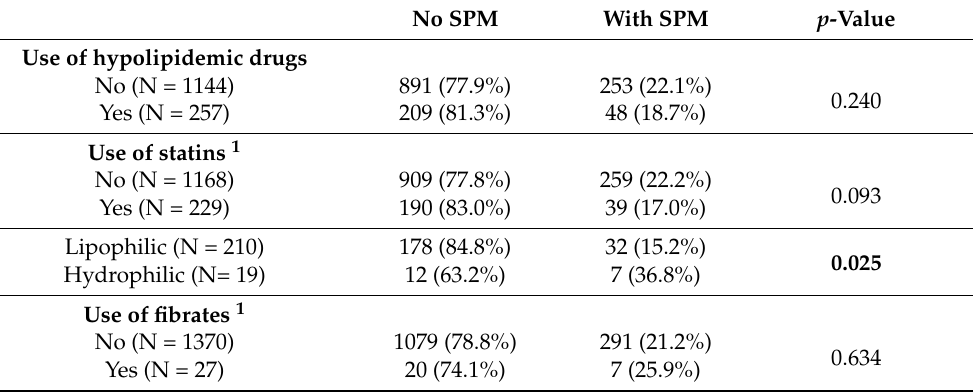
malignancy in patients with colorectal cancer